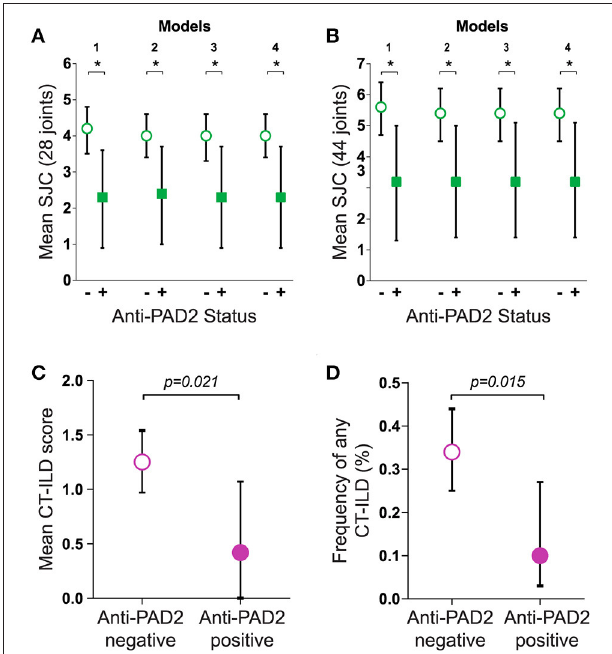
FIGURE 2 | Anti-PAD2 antibodies are associated with fewer swollen joints and less ILD. Baseline mean SJC of (A) 28 or (B) 44 joints according to anti-PAD2 antibody status is shown. (A,B) Model 1 is unadjusted. Model 2 is adjusted for sex, BMI, RA duration, HAQ, biologic use. Model 3 is additionally adjusted for RF, anti-CCP, anti-PAD3/4, and SE. Model 4 is additionally adjusted for CRP. (C) The mean CT-ILD score, and (D) frequency of ILD adjusted for age, ever and current smoking, RF, anti-CCP, anti-PAD3/4, DAS28, and current biologic use is shown according to anti-PAD2 antibody status. (A–D) The average values, group 95% confidence intervals, and error bars are shown. A p < 0.05 was considered significant (*).